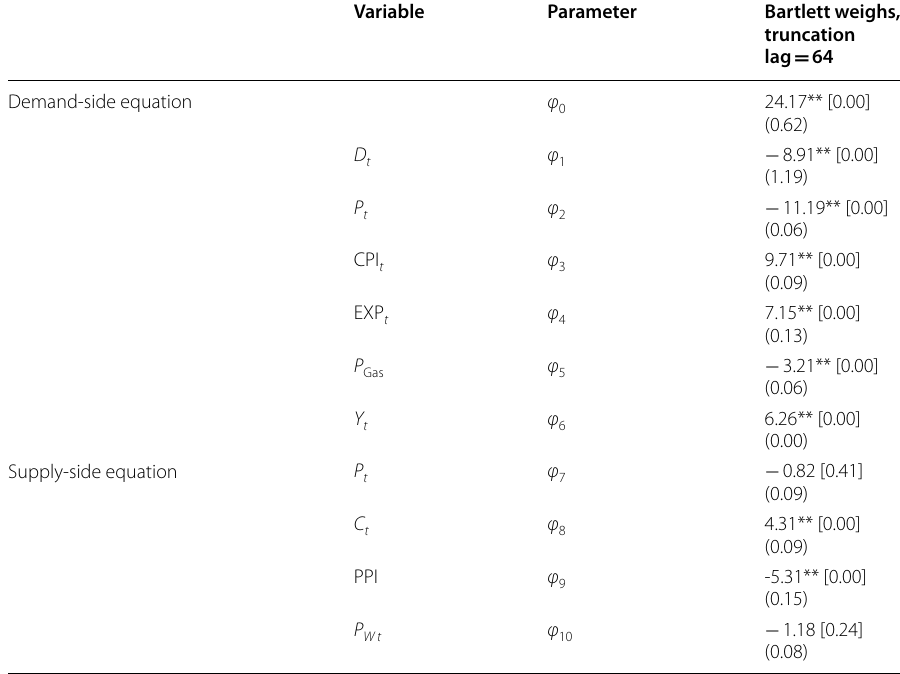
Table 2 Static disequilibrium switching estimation